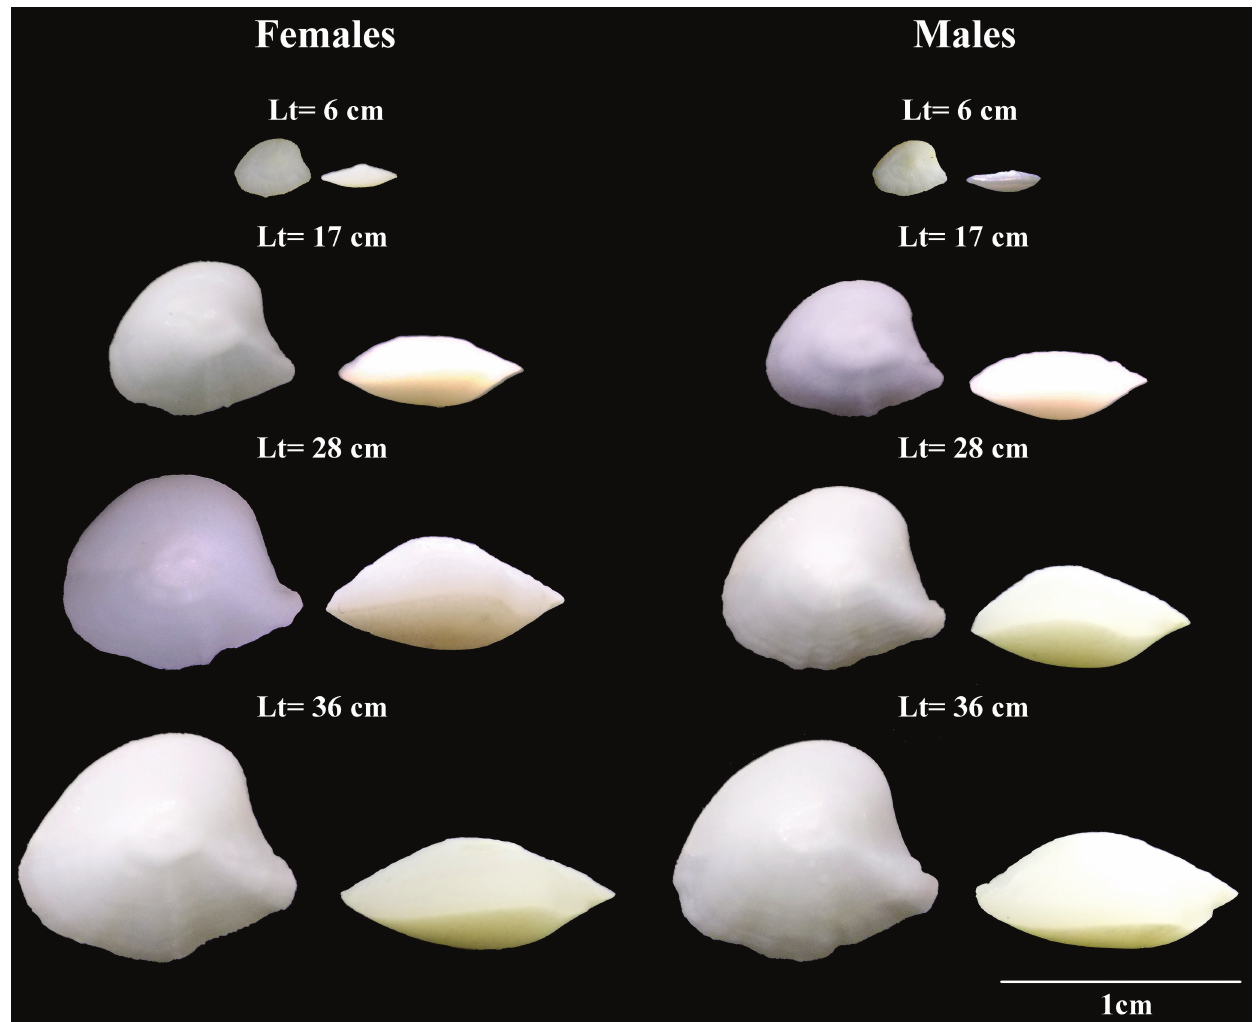
Fig. 3. Lapilli otoliths from Genidens genidens females and males from Guanabara Bay, Rio de Janeiro, southeastern Brazil. Tab. 1. Relative Genidens genidens females growth ratios, calculated by the Huxley (1924) and the polyphasic allometric models (SE = standard error), in specimens obtained from Guanabara Bay, Rio de Janeiro, southeastern Brazil.